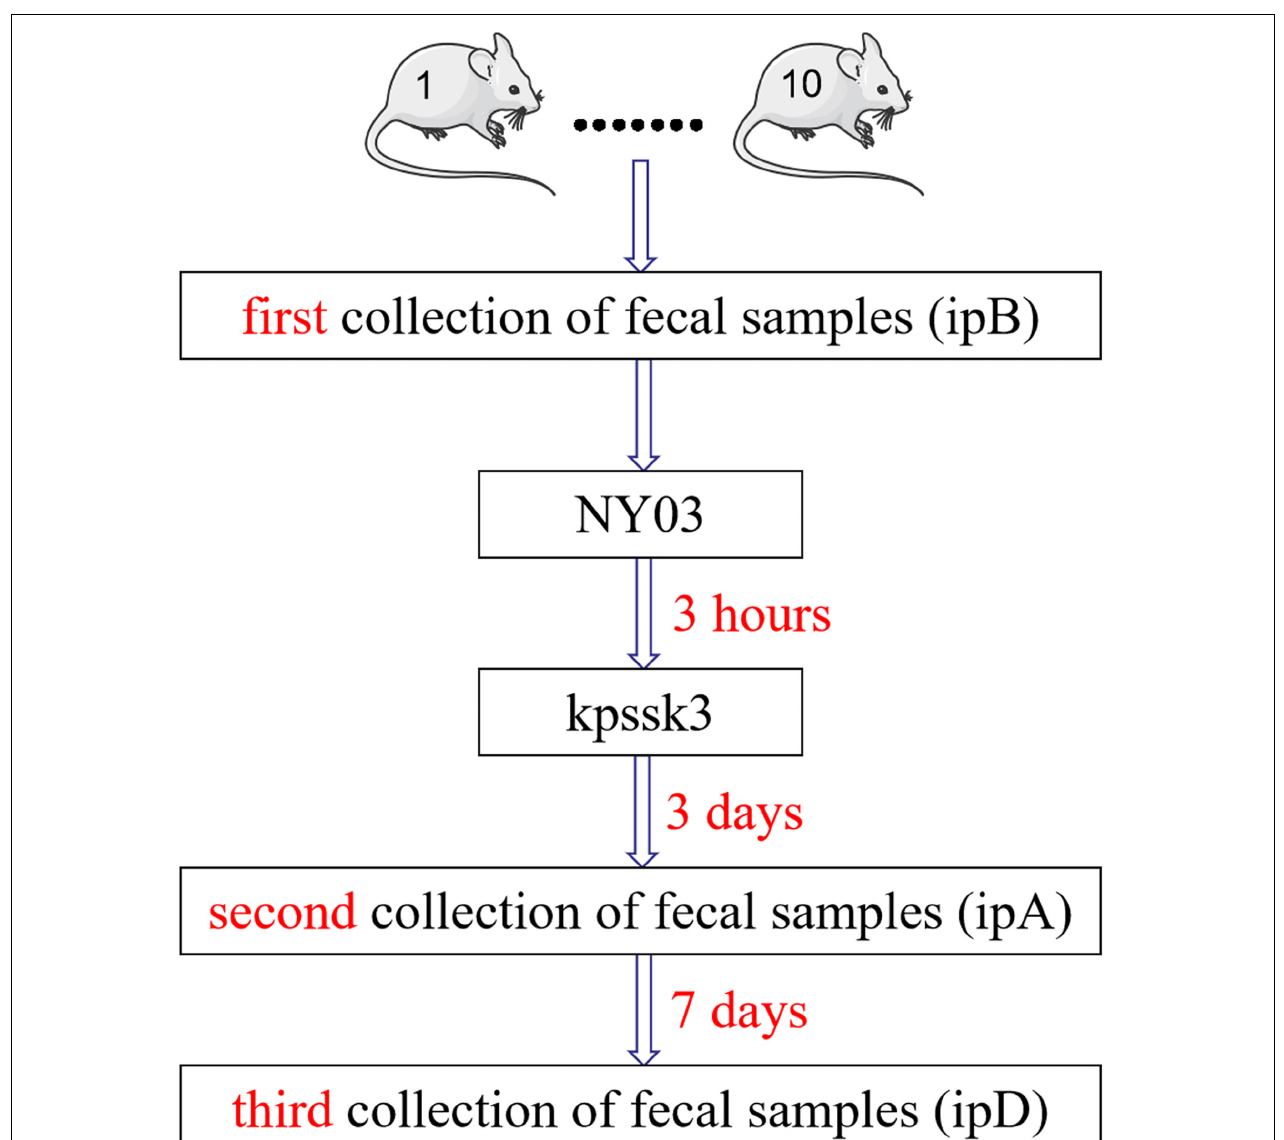
FIGURE 1 | Diagrammatic sketch of the fecal sample collection